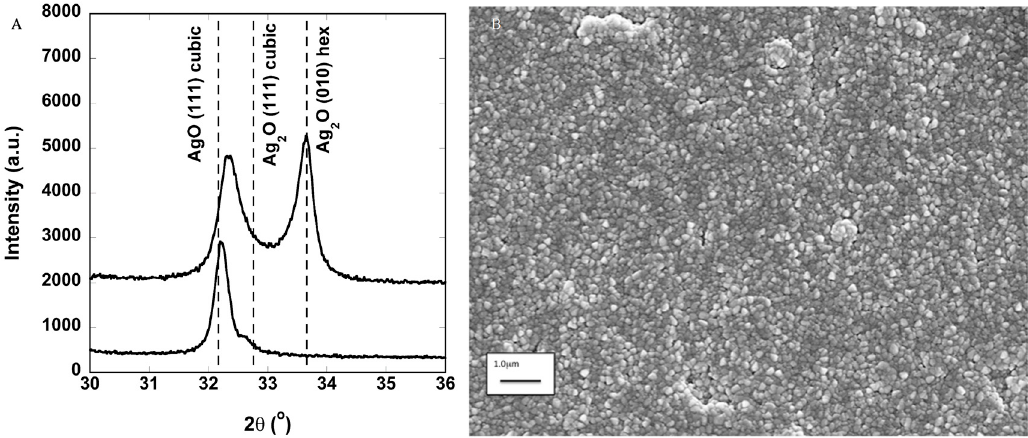
Figure 1. ( A ) Plot of the X-ray diffraction intensity versus 2 θ showing single phase cubic AgO and mixed phase AgO and Ag 2 O deposited at lower oxygen partial pressure; ( B ) Scanning electron micrograph showing the typical surface microstructure of the silver oxide deposited at room temperature. The microstructure can be impacted by deposition pressure, deposition power, oxygen partial pressure, and coating thickness.